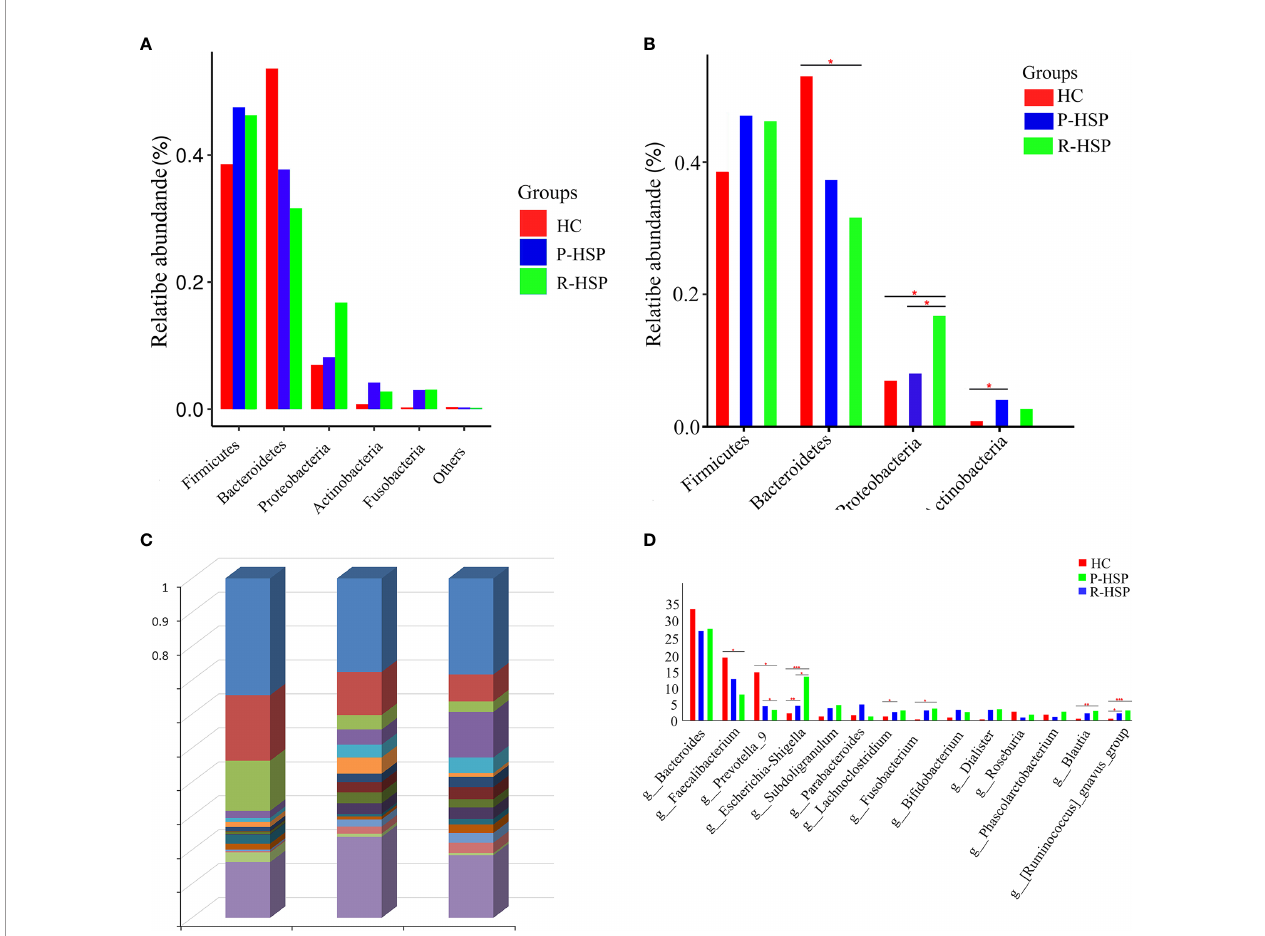
FIGURE 3 | Histogram of relative abundance (%) of intestinal fl ora at different taxonomic levels in children with primary and recurrent HSP and healthy controls. (A) Relative abundance of each phylum in two HSP groups and a healthy control group. Firmicutes, Bacteroidetes, Proteobacteria, and Actinobacteria phyla encompassed most bacteria in the fecal samples of patients with HSP and healthy controls. The sum of the percentages reached 90% in each group. (B) Signi fi cance of abundance of the top four community bacteria at the phylum level. We observed that Firmicutes and Bacteroidetes constituted the most abundant phyla in both HSP and healthy control groups, but with no signi fi cant difference between the primary HSP and healthy control groups. No signi fi cant difference was observed in the microbial composition at the Firmicutes and Actinobacteria level between primary and recurrent HSP groups or between recurrent HSP and healthy control groups. (C) The microbiome composition in all three groups at the genus level. The fi gure shows the top 15 species in each group based on their relative abundances. Bacteroides, Faecalibacterium , Parabacteroides , Escherichia-Shigella , and Prevotella_9 were the top fi ve genera in the primary HSP group, and Bacteroides, Escherichia-Shigella , Faecalibacterium , Subdoligranulum , and Fusobacterium were the top fi ve genera in the recurrent HSP group. In the healthy controls group, the dominant microbiota was Bacteroides , Faecalibacterium , Prevotella_9 , Escherichia-Shigella , and Roseburia . (D) Signi fi cance of abundance of the 14 community bacteria at the genus level. The Escherichia-Shigella , Blautia , and Ruminococcus_gnavus were more abundant in recurrent HSP group than in primary HSP and healthy control groups, while Faecalibacterium and Prevotella_9 were more abundant in the healthy control group compared with that in HSP groups. * P < 0.05, ** P < 0.01, *** P <